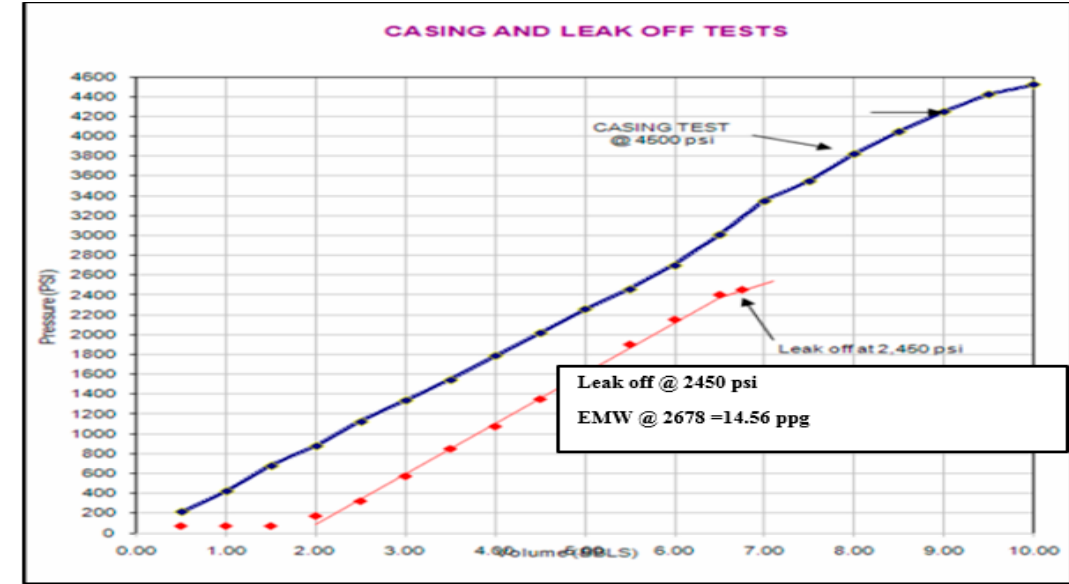
Figure 24. Leak-off test at 2678 m TVD for Well N-8.